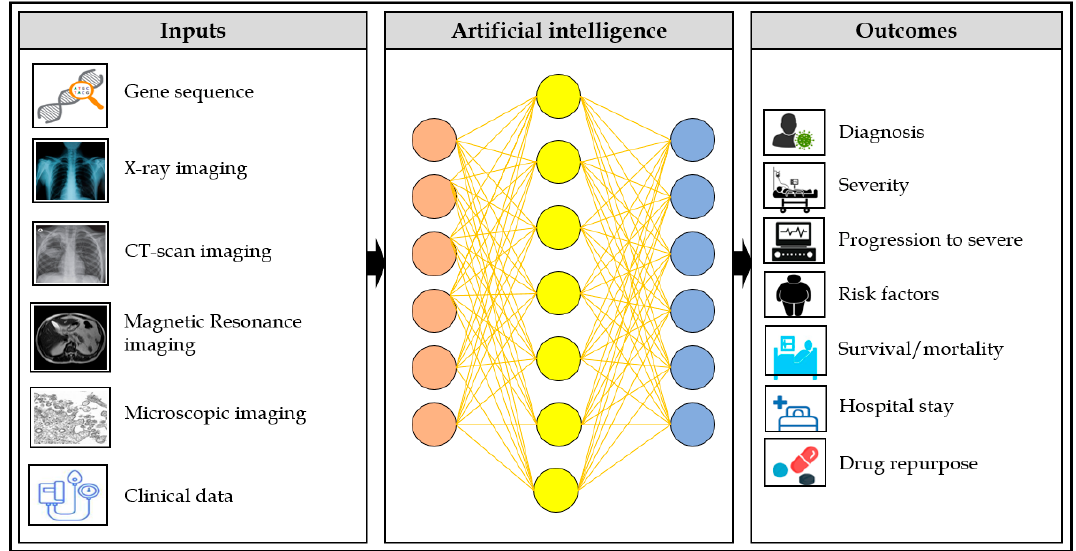
Figure 1. Application of AI to fight COVID-19.